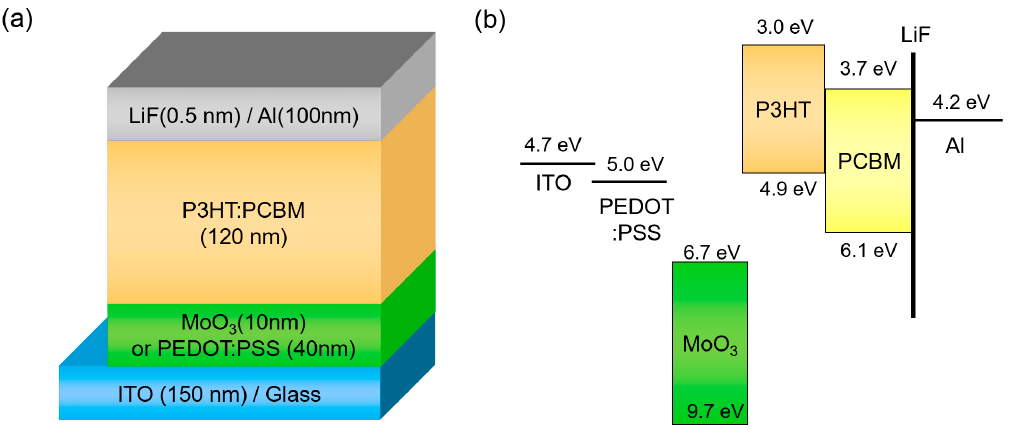
Figure 1. ( a ) Device structure and ( b ) energy band diagram of organic solar cell (OSC) with different hole-extraction layers (HELs).